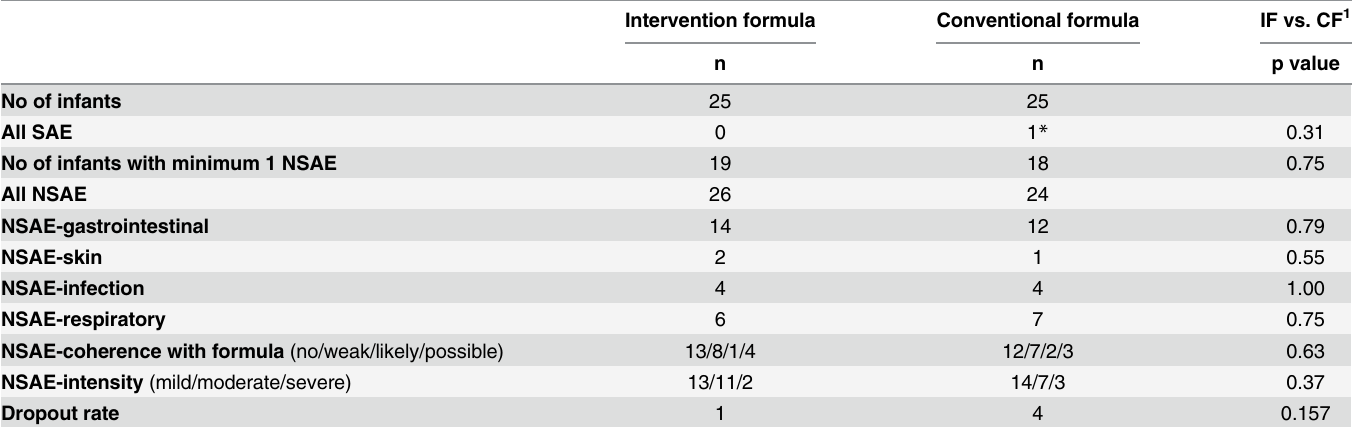
Table 2. Summary of Adverse events.